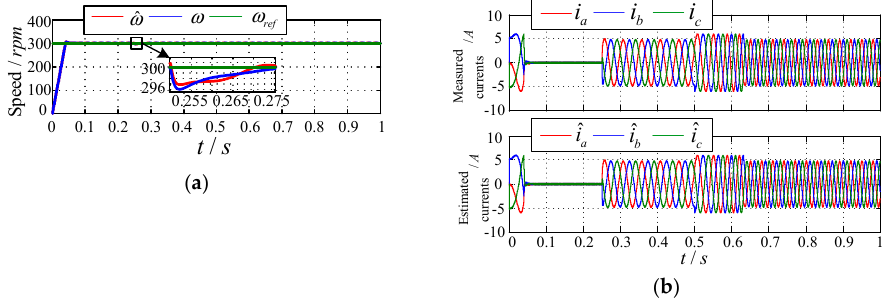
Figure 5. The simulation waveforms of PMSM drive system based on the composite sliding mode observer in the case of disturbance. ( a ) The given speed ω ref , the measured speed ω , and estimated speed 𝜔(cid:3549) ; ( b ) The measured signal i abc and estimated signal 𝚤̂ (cid:3028)(cid:3029)(cid:3030) of the three-phase stator current. Analysis of the waveforms shows that the interference signal added to the system does not affect the operation of the composite sliding mode observer and the estimated signal still matches the